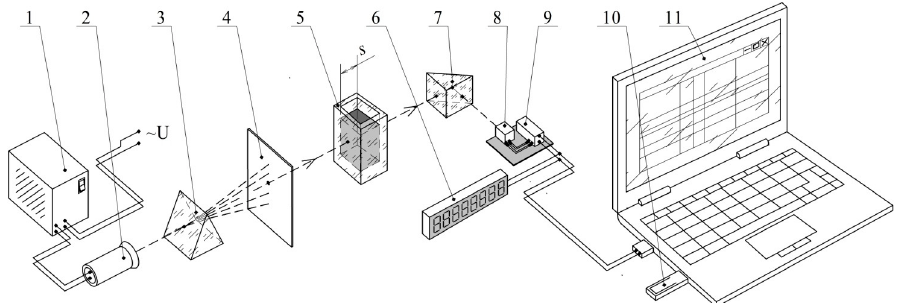
Figure 9. Pilot unit for evaluation of optical oil properties. 1—power supply source; 2—emitter sensor; 3—prism; 4—cross-section with the probe; 5—hood with the fluid sample; 6—display;